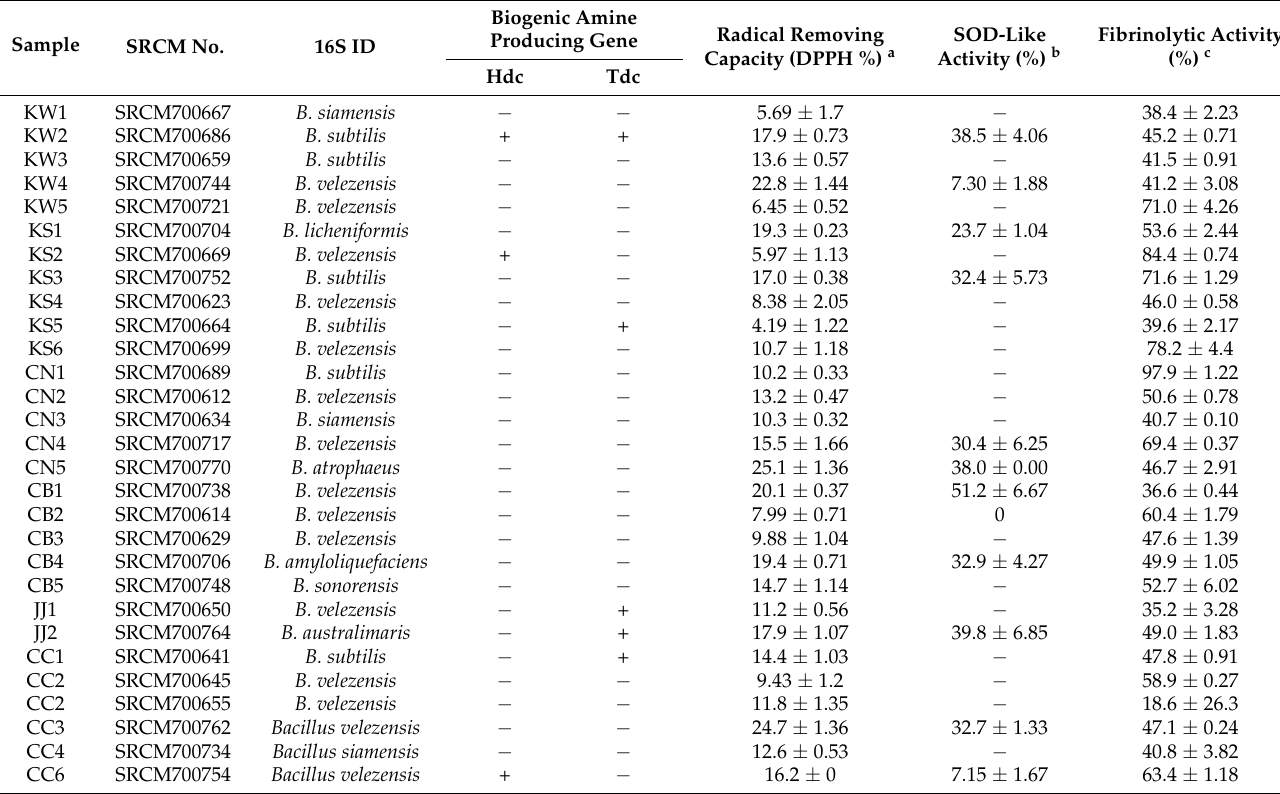
Table 2. Characteristics of isolated Bacillus spp. from each traditionally made